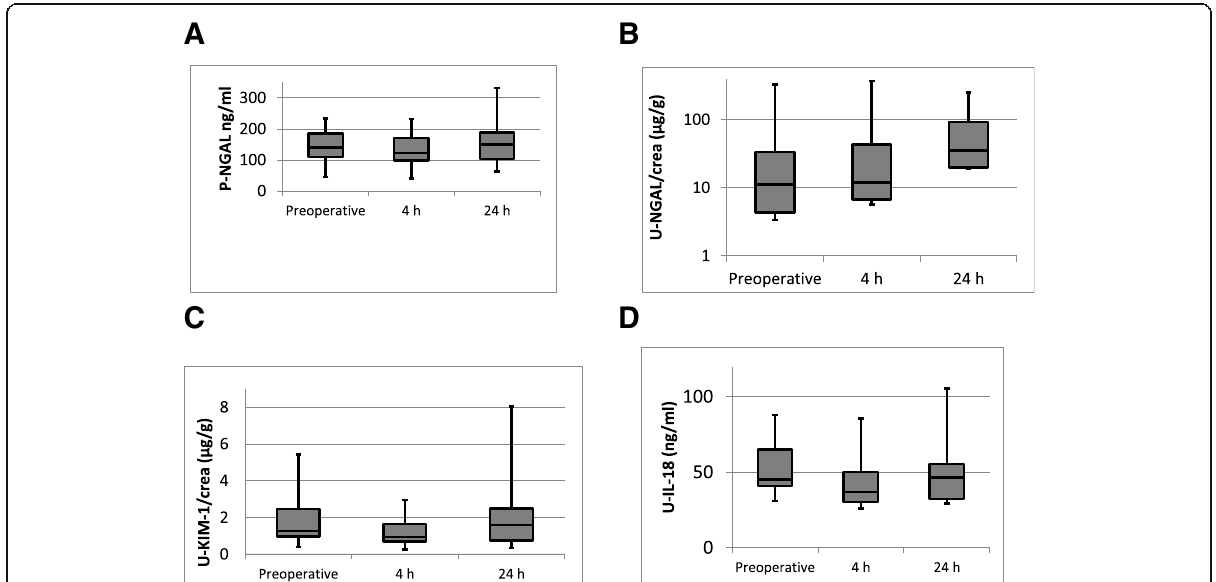
Fig. 1 a Plasma neutrophil gelatinase associated lipocalin (NGAL) concentrations preoperatively, at 4 h and at 24 h after surgery presented as box and whisker plots with median, lower and upper quartiles, minimum and maximum. b Urine neutrophil gelatinase associated lipocalin/creatinine (U-NGAL/crea) concentration ratios preoperatively, at 4 h and at 24 h after surgery presented as box and whisker plots with median, lower and upper quartiles, minimum and maximum. c Urine kidney injury molecule-1/creatinine (U-KIM-1/crea) concentration ratios preoperatively, at 4 h and at 24 h after surgery presented as box and whisker plots with median, lower and upper quartiles, minimum and maximum. d Urine interleukin − 18 concentrations preoperatively, at 4 h and at 24 h after surgery presented as box and whisker plots with median, lower and upper quartiles, minimum and maximum